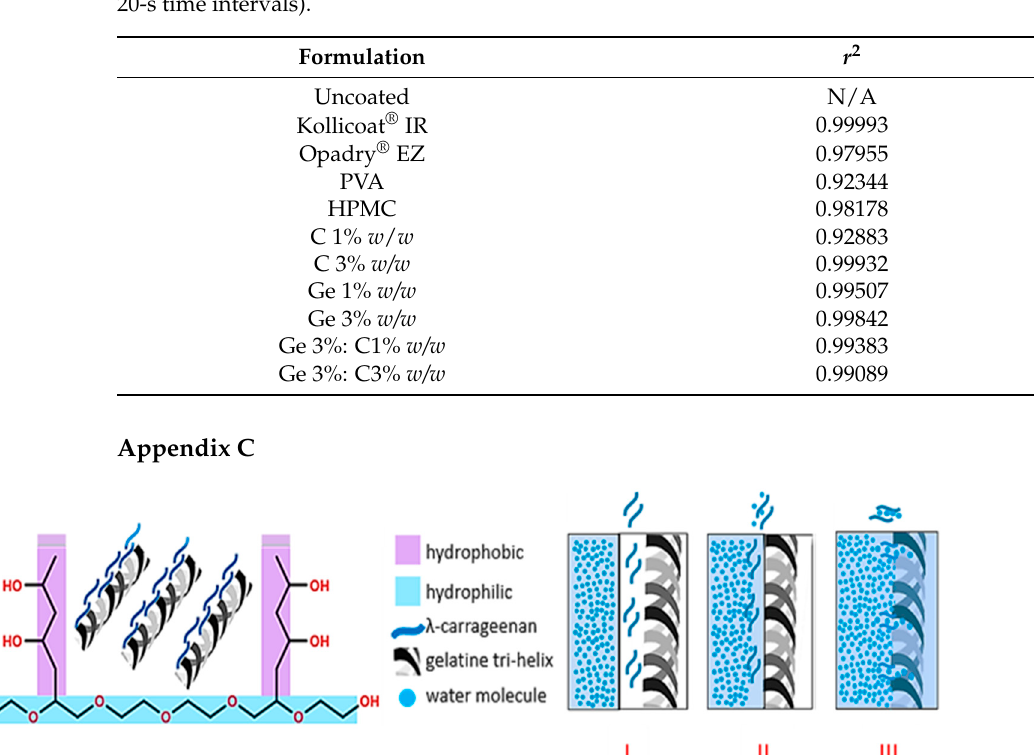
Table A1. Contact angle with respect to the wetting time of film-coated tablets (immediate, 10-, and 20-s time intervals).